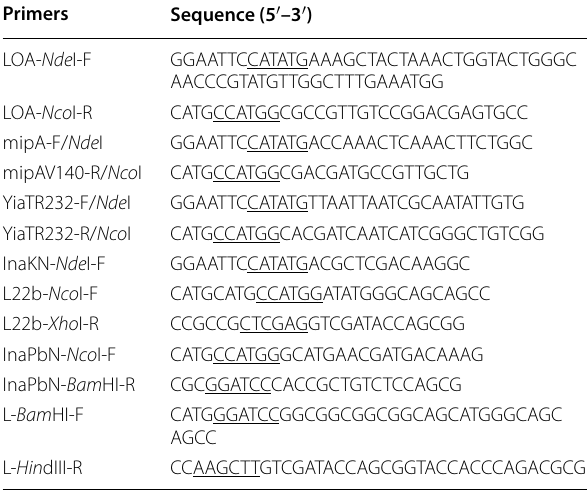
Table 3 Primers used in this